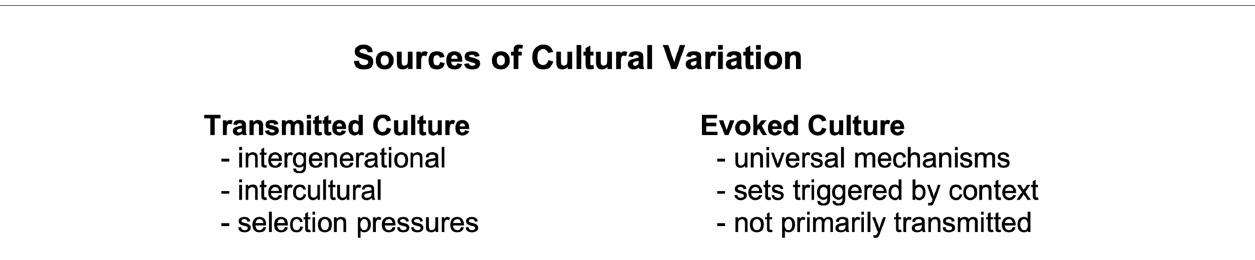
FIGURE 2 Cosmides and Tooby (1992) conceptualized that there are two sources of cultural variation in thought and behavior. The traditional explanation of within- location similarity and between-location differences is that culture is transmitted, mostly between generations but also localities. Practices are under selection pressures that determine spread. A second explanation of local similarity is that our universal, evolved information-processing mechanisms are context-dependent. When the local environment changes, certain cultural and behavioral responses are evoked based on universal predispositions— without these responses having been socially transmitted. Evoked and transmitted culture usually operate together. In matters of mating, a changed sex ratio could evoke a polygynous mating strategy in some individuals without these having been influenced by polygynous ideology or